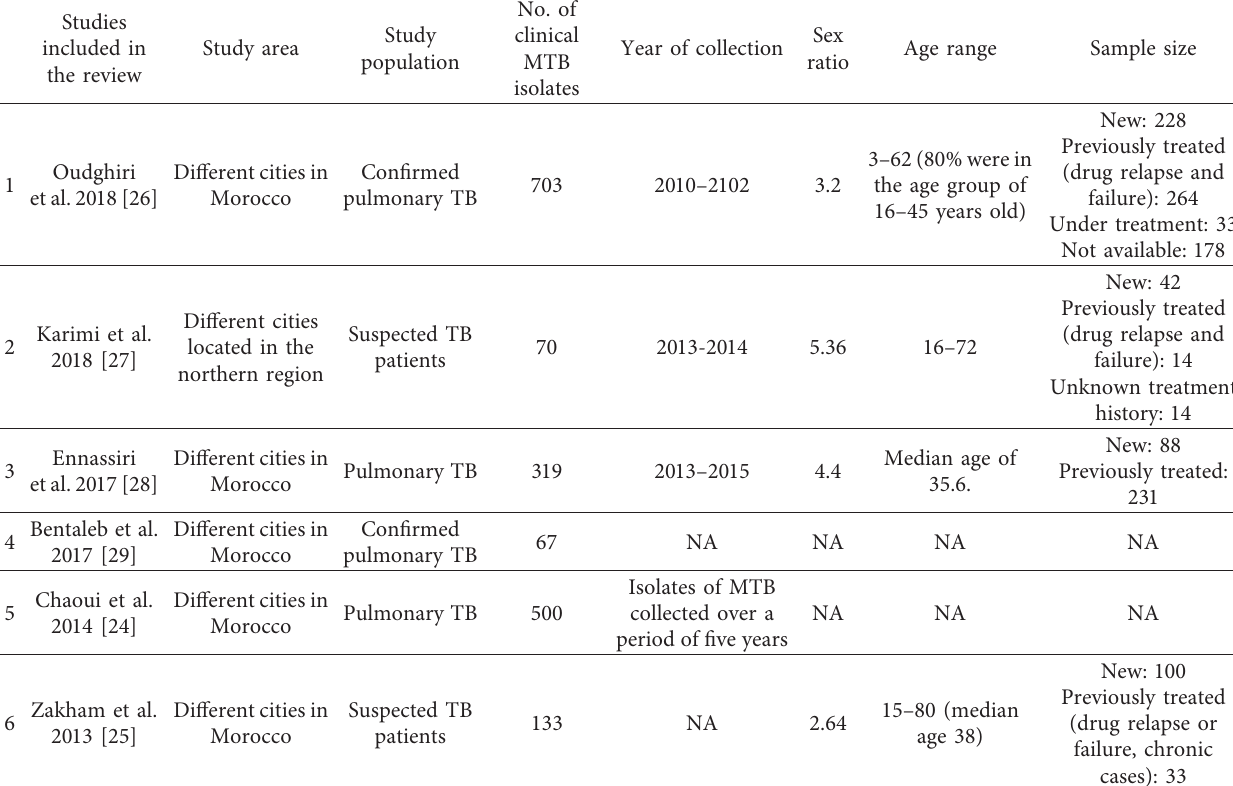
Table 1: Characteristics of studies included in the